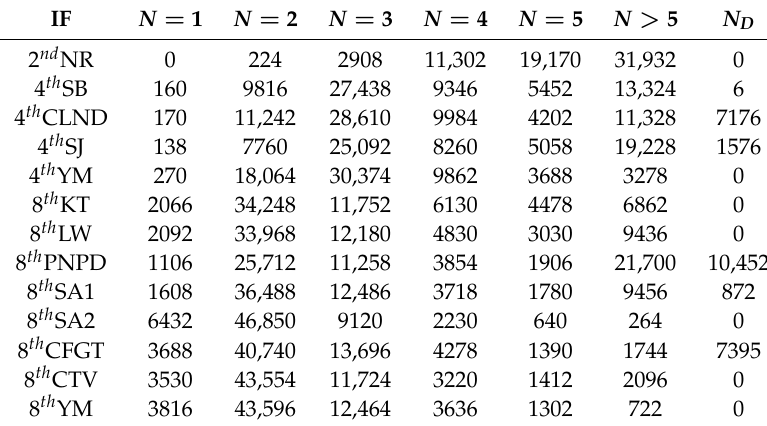
Table 9. Results of the polynomials p 2 ( z ) = z 3 − 1.